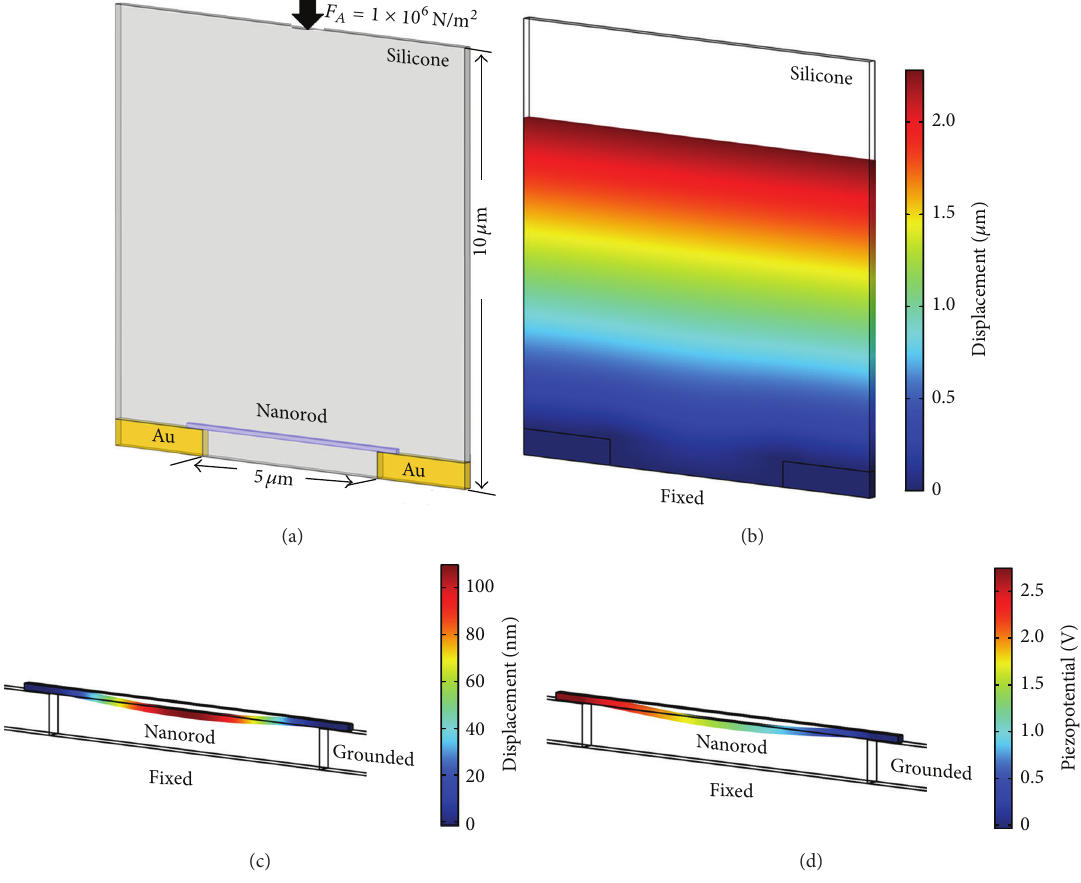
Figure 8: Static simulation of the electromechanical conversion behavior of a lateral stretch device. (a) Schematic diagram. (b) Deformation of silicone. (c) Deformation of nanorod. (d) Piezoelectric potential of